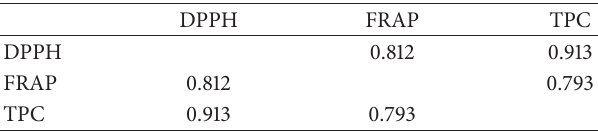
Table 2: Correlation between total phenolic content (TPC), DPPH radical scavenging ability (DPPH), and ferric-reducing antioxidant power